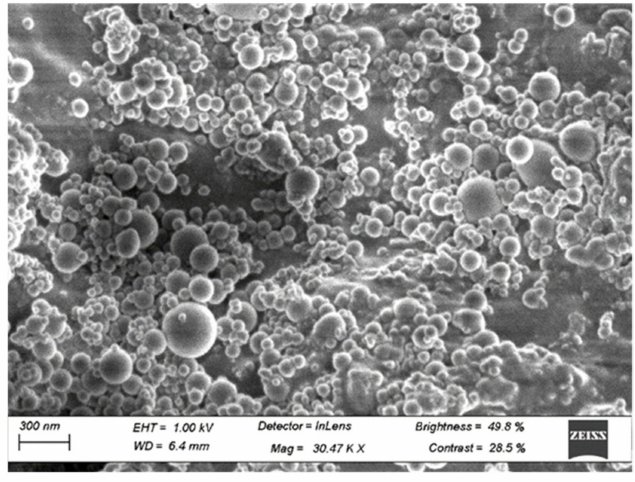
Figure 5. SEM results of